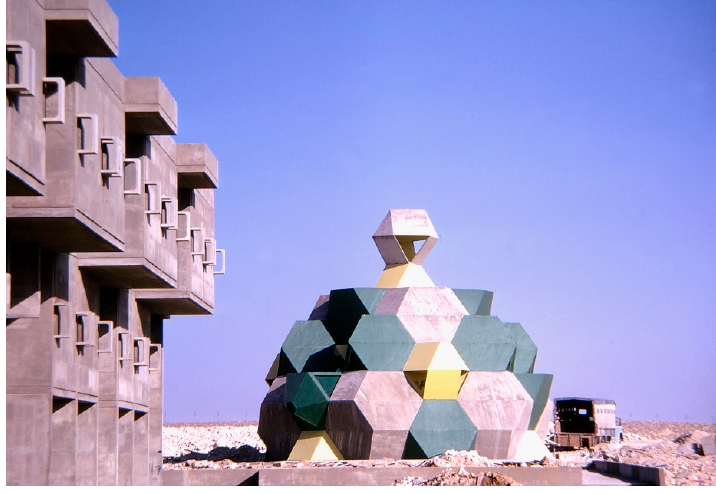
Figure 6. The Military Officers’ Academy Synagogue in Mitzpe Ramon. Architects: Alfred Neumann